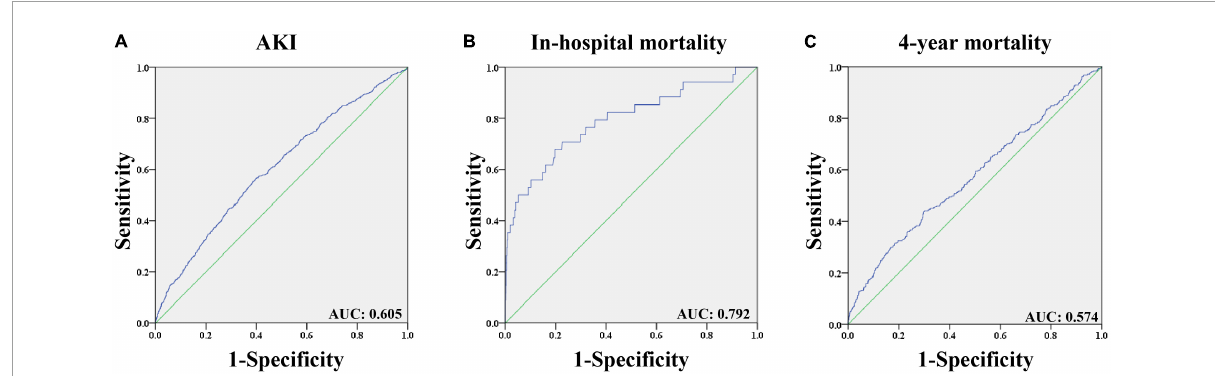
FIGURE2 The receiver operating characteristic curves of predictive value of CVP for outcomes in patients undergoing CABG. (A) Predictive value of CVP for AKI; (B) Predictive value of CVP for in-hospital mortality; (C) Predictive value of CVP for 4-year mortality. AKI: Acute kidney injury. AUC: Area under the curve. CABG: Coronary artery bypass grafting. CVP: Central venous